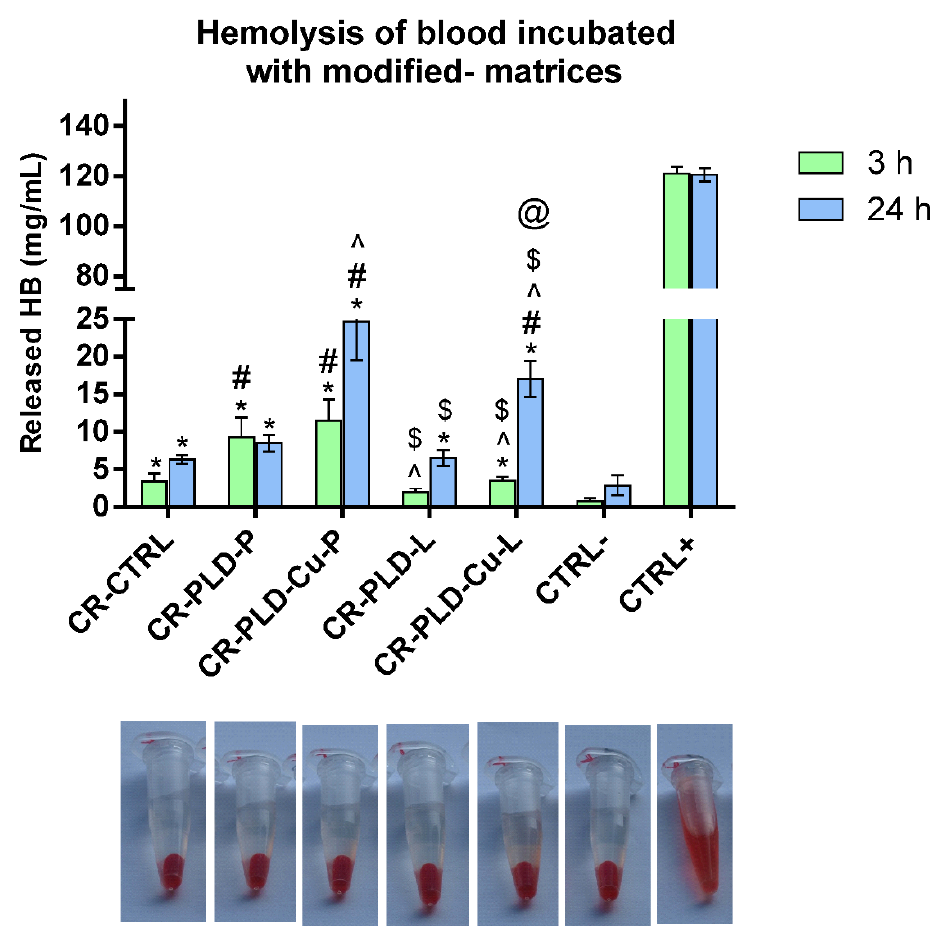
Figure 5. Hemolysis in blood incubated with control and poly(L-DOPA)-modified curdlan hydrogel samples with immobilized oxidoreductases. (*) symbol indicates statistically significant differences between the negative control and other samples, (#) symbol indicates statistically significant results between CR-CTRL sample and other samples, (^) symbol indicates statistically significant results between CR-PLD-P sample and other samples, ($) symbol indicates statistically significant results between CR-PLD-Cu-P sample and other samples, (@) symbol indicates statistically significant results between CR-PLD-L sample and other samples. *, #, ^, $, @ symbols indicate statistically significant results according to One-way ANOVA with post-hoc Tukey’s test for 3 h and 24 h ( p < 0.05), respectively in comparison with appropriate sample variants for each time point.